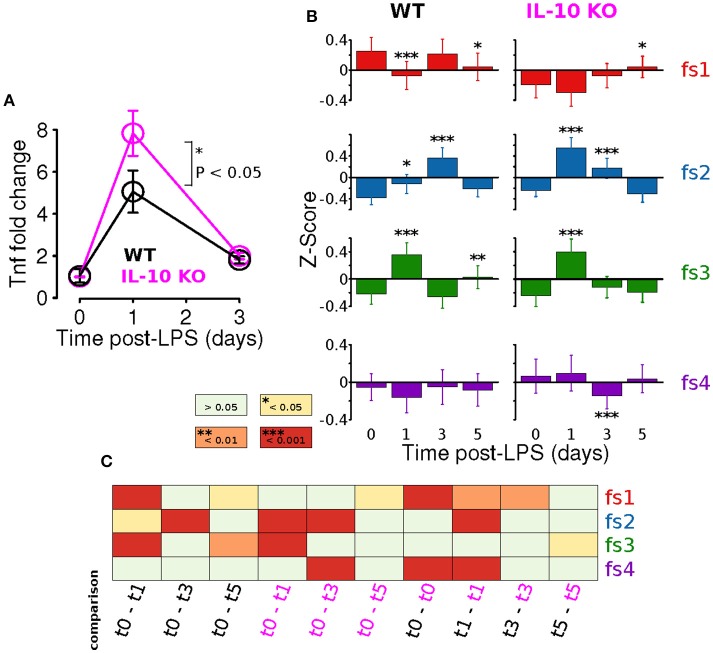
IL-10 restrains TNFα adaptation and regulates specific morphological features. (A)
In vivo CNS gene expression of TNFα in WT and IL-10−/− LPS-treated mice show that the absence of IL-10 is associated with an enhanced LPS response and corresponding enhanced adaptive recovery to baseline (two-way ANOVA with with Sidak's multiple comparisons P = 0.0147, n = 4 mice per group, brain tissue). (B) For both WT and IL-10−/−, the arithmetic means across each feature set (fs1-4) was computed at the four time points (t = 0, 1, 3, and 5 days). Temporal dynamics of each feature set was analyzed using a two-way ANOVA and p-values based on a Fisher LSD post-hoc test with a Sidak correction. (C) The heatmap depicts corrected p-values for a focused set of post hoc comparisons (columns) applied for each feature set (rows). For instance, the first column shows results for the comparison of the WT means at time 0 and time 1 day, the third column shows the comparison of the IL-10−/− means at time 0 and time 1 day, and the last column shows the comparison of the WT and IL-10−/− means at time 5 days.